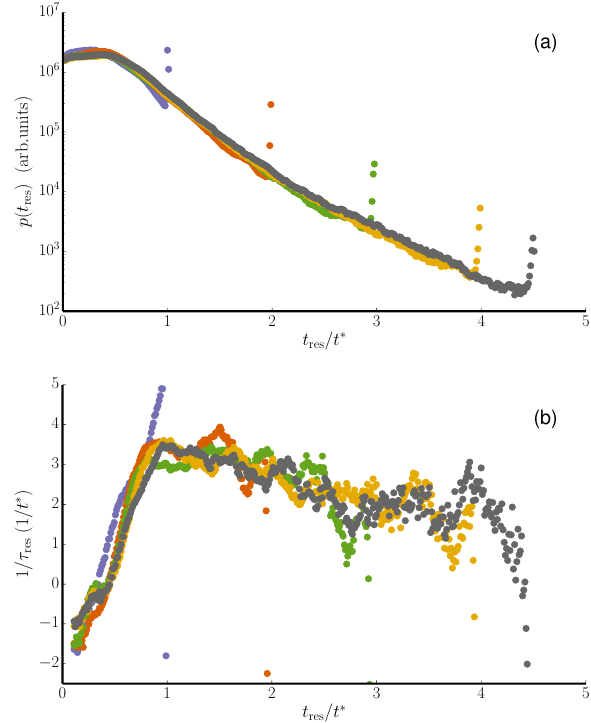
Figure 3. (a) Histogram of cloud-top residence times. (b) Decay time of droplets at cloud top by Eq. (4). The colors stand for the time elapsed after initiating the residence times: t ∗ , 2 t ∗ ,3 t ∗ ,4 t ∗ ,4 . 5 t ∗ . droplets that have reached the cloud top behave as convec- tive